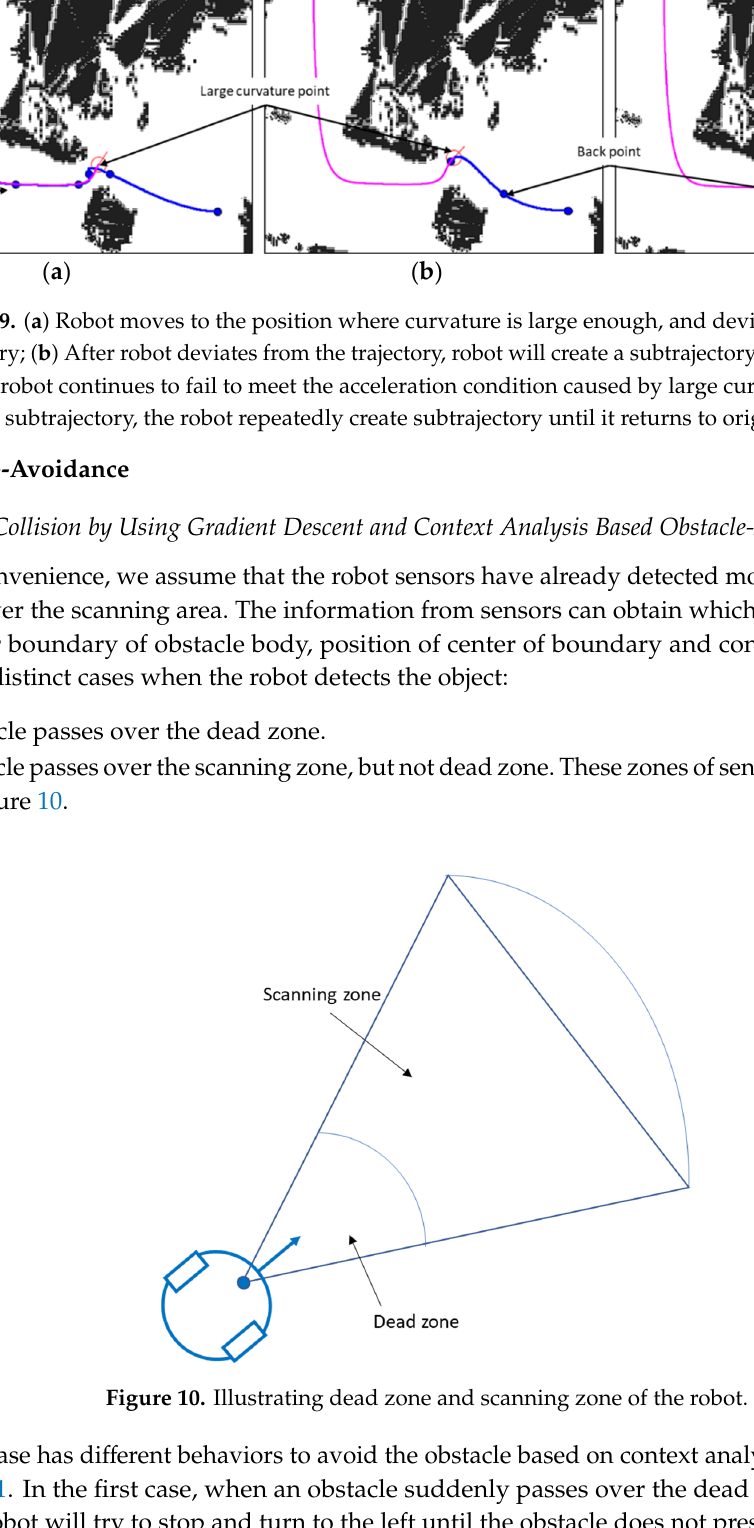
Figure 8. Re-path algorithm flow chart.